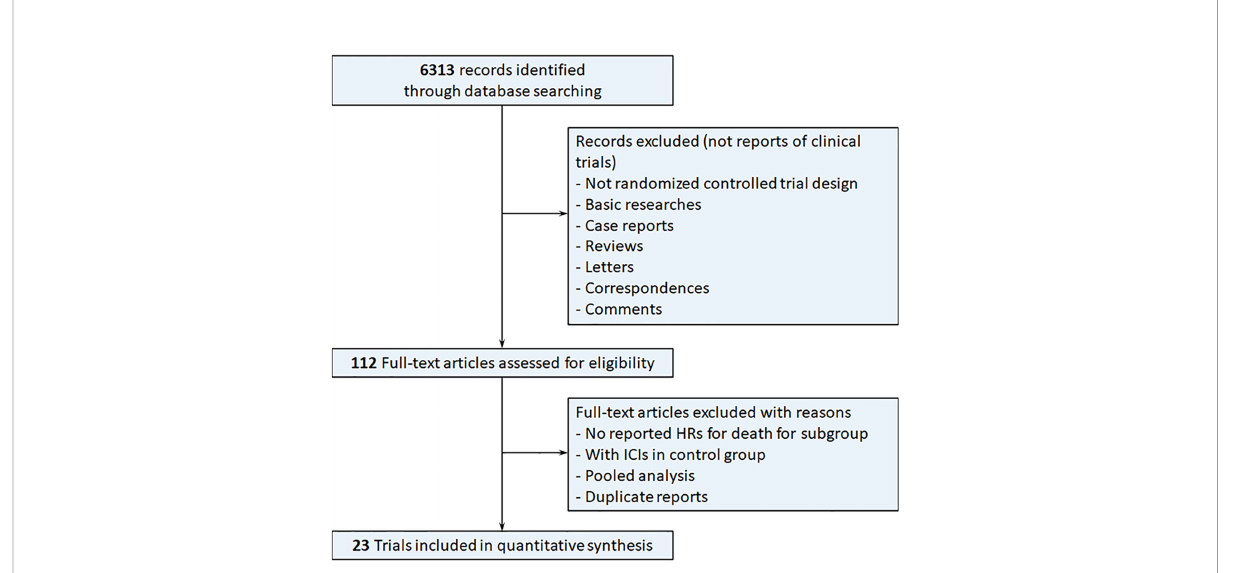
FIGURE 1 Flow diagram of the study selection process. HRs, hazard ratios; ICIs, immune checkpoint